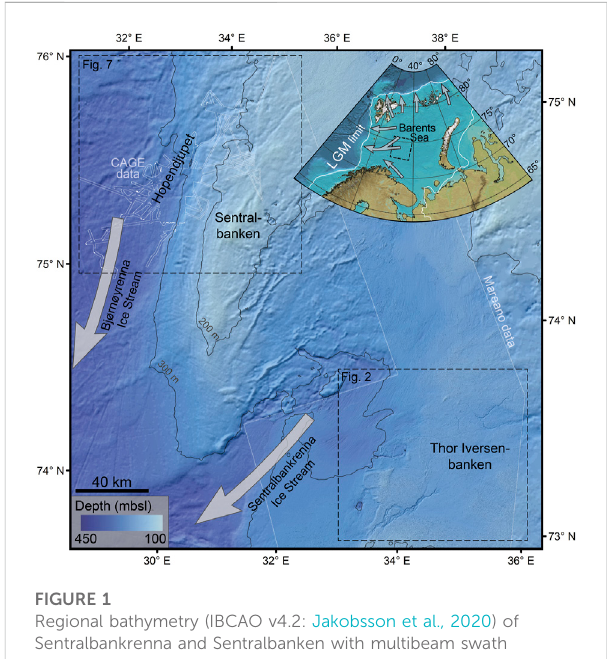
FIGURE 1 Regional bathymetry (IBCAO v4.2: Jakobsson et al., 2020) of Sentralbankrenna and Sentralbanken with multibeam swath bathymetric data extents collected by the Centre for Arctic Gas Hydrates, Environment and Climate (CAGE) and provided by the MAREANO Programme overlain in white. White arrows show the fl ow directionofformericestreams. Insetmaphighlights theglacialsetting within the wider Barents Sea system, with arrows showing the fl ow direction of major palaeo-ice streams and the white line indicating maximum ice margin extents during the Last Glacial Maximum